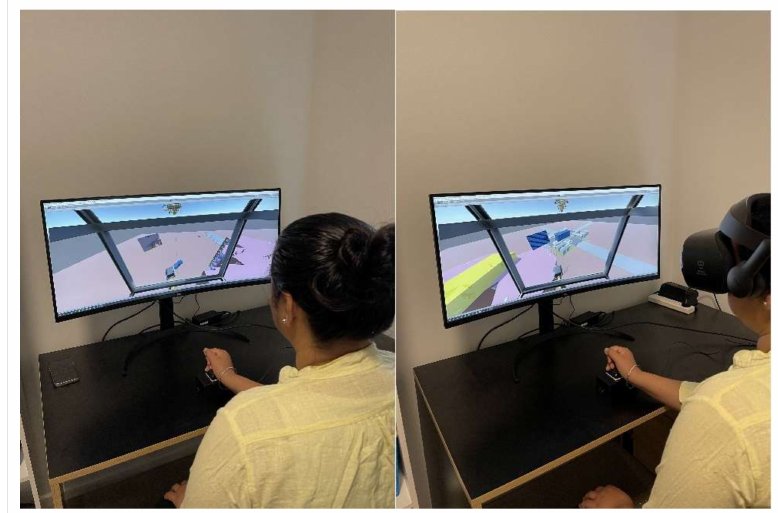
Figure 3. Simulation of heavy machinery operation with flat screen (left) and VR Headset (right).